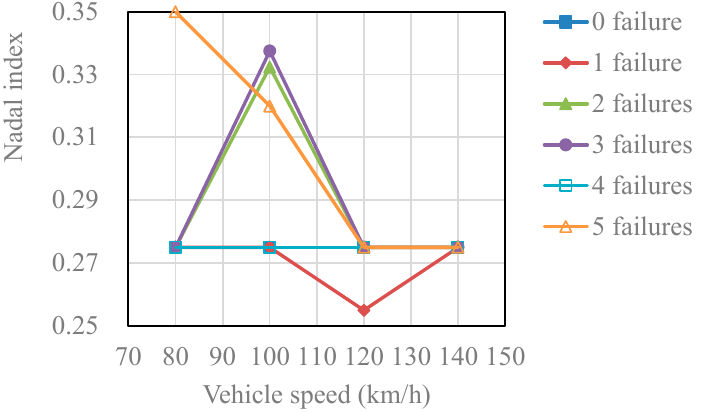
Figure 9. The Nadal index under different cases.